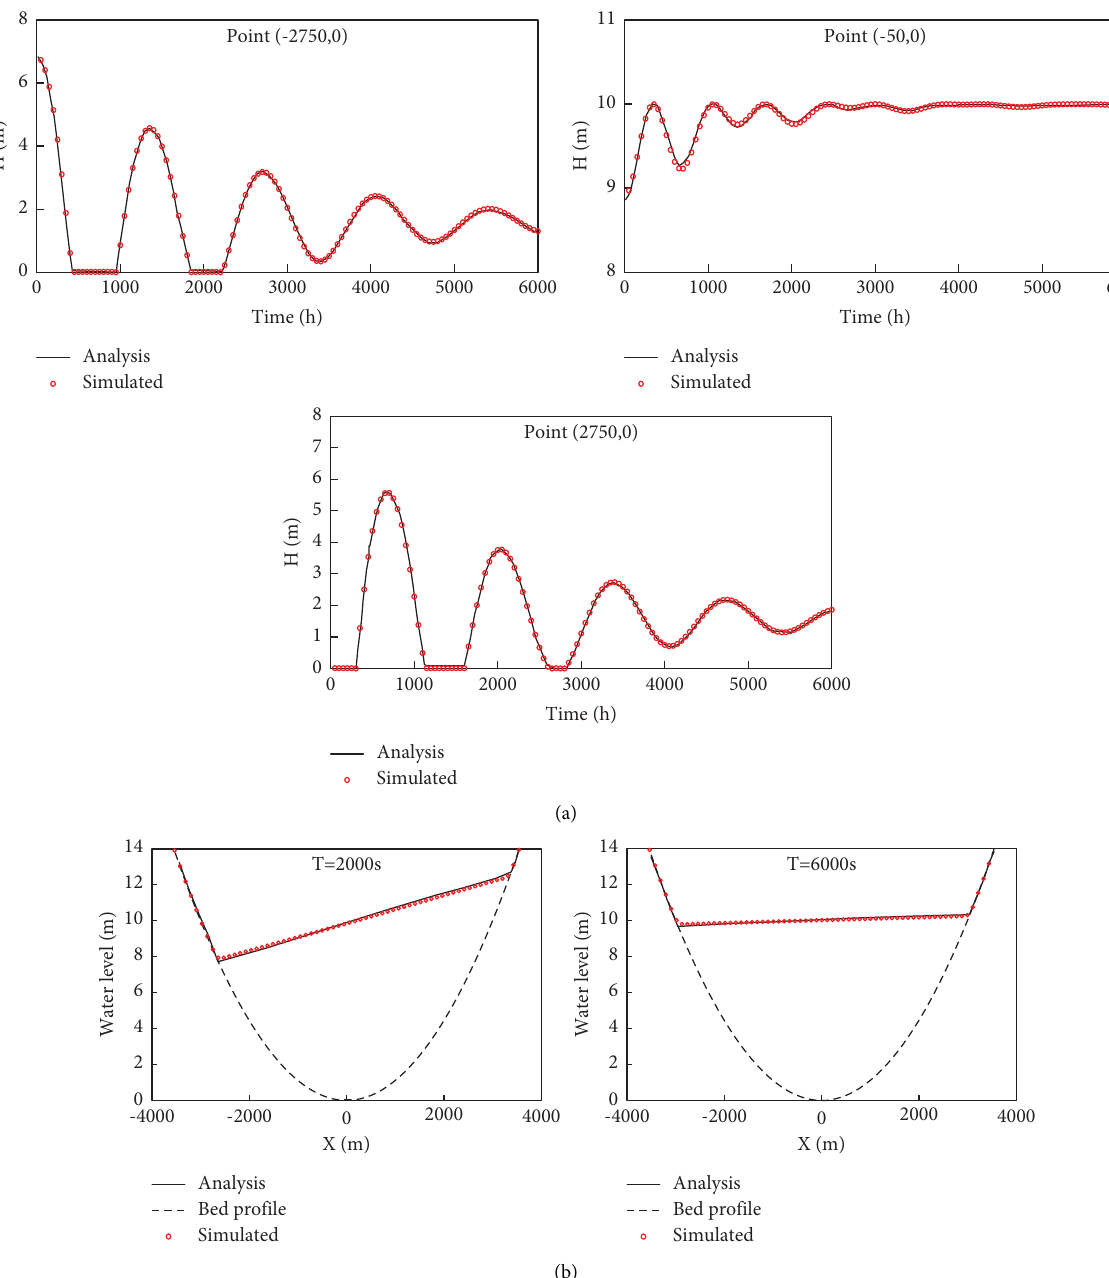
Figure 1: Comparison of the numerical results and the theoretical solution in the presence of bed friction. (a) The water depths at different gauges. (b) The water levels at different